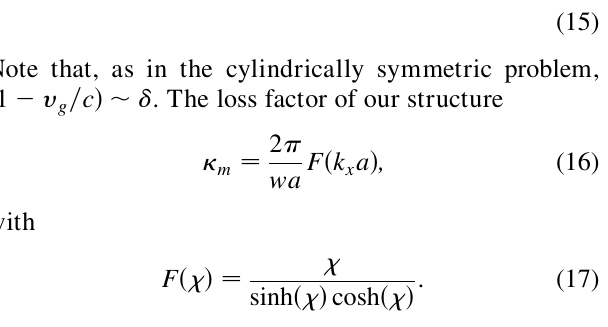
(cid:7) (cid:23)= (cid:3) a 2 k c (cid:5) r r